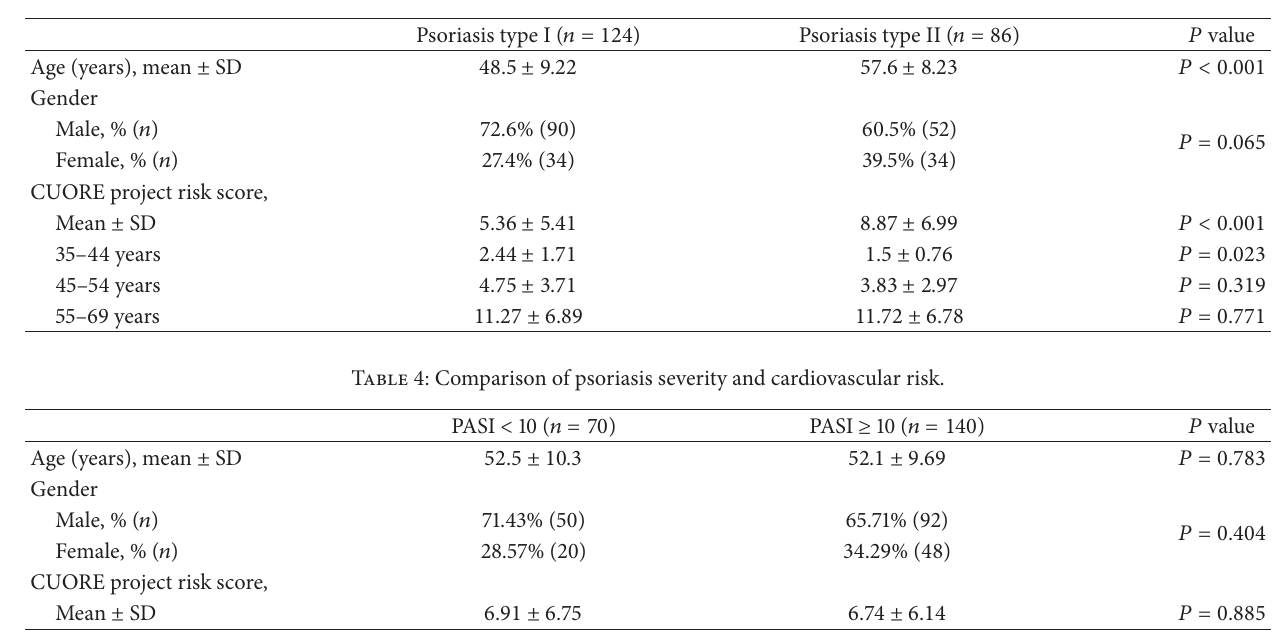
Table 3: Comparison of psoriasis type and cardiovascular risk.